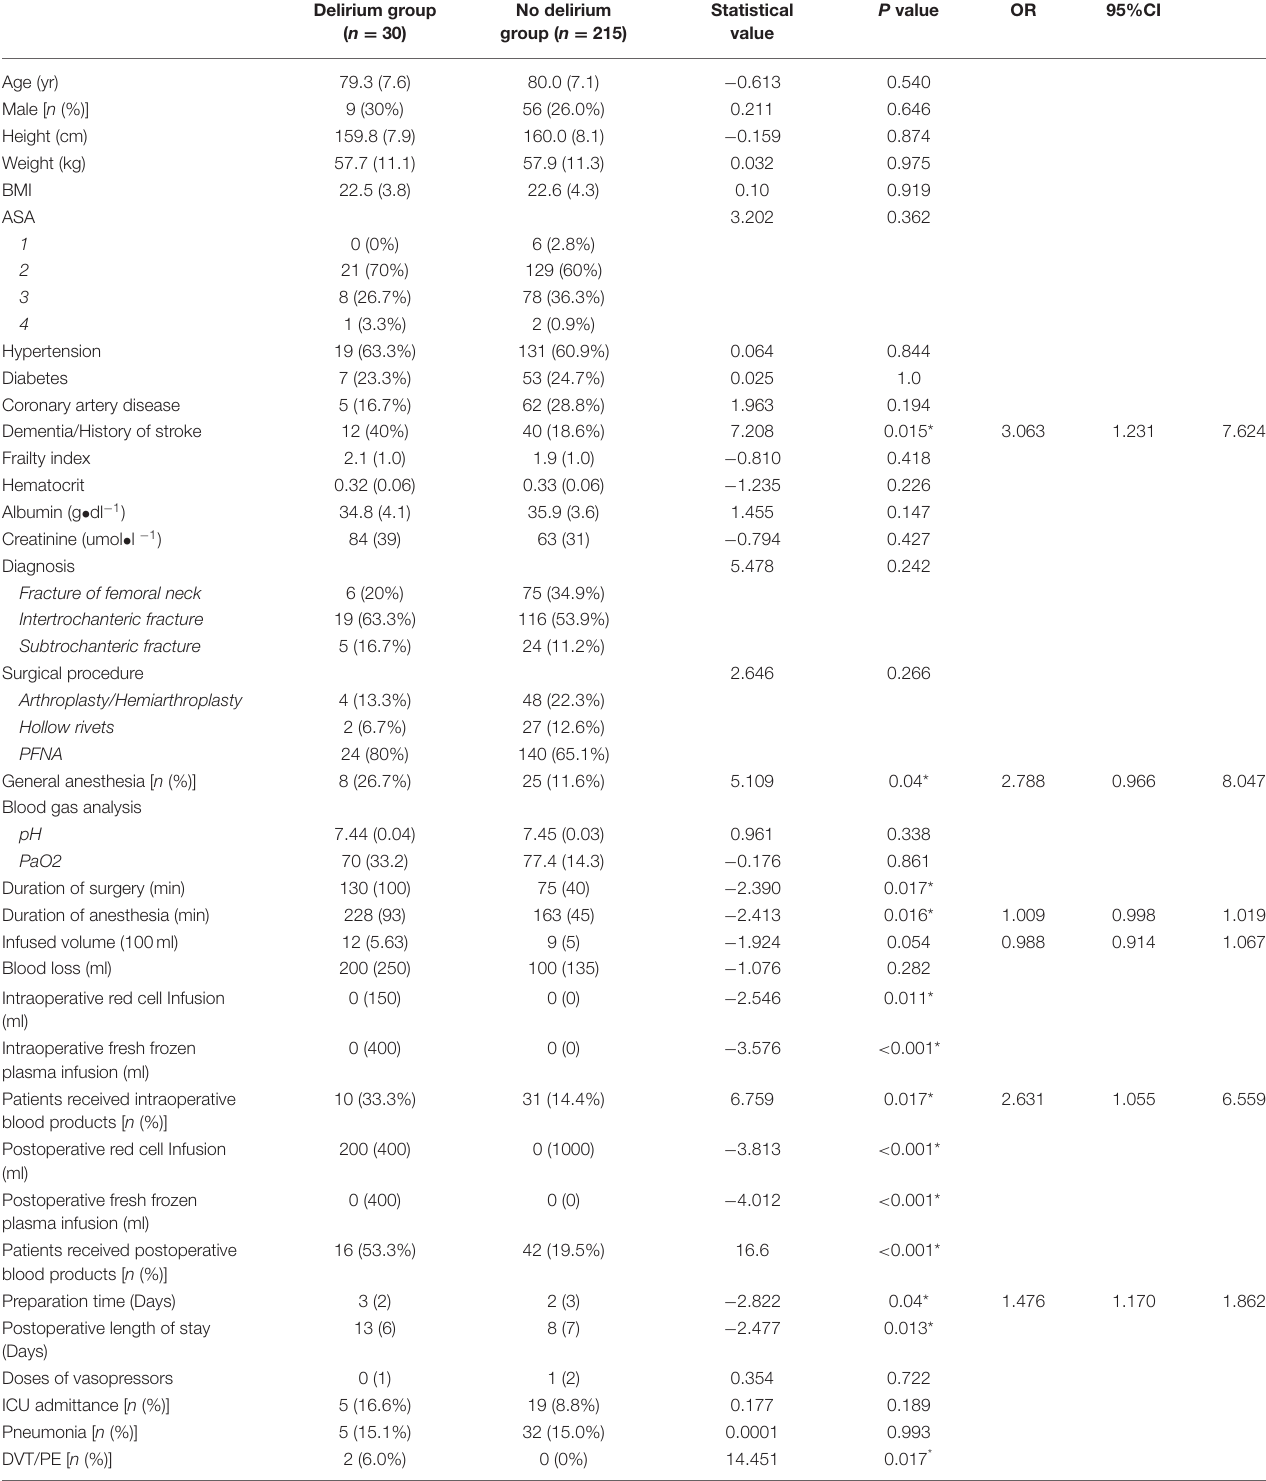
TABLE 1 | Univariate and multivariate analysis of perioperative